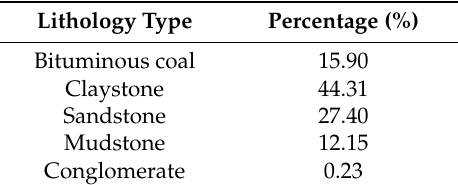
Table 1. The results of lithology modeling in the region of Pawłowice–Mizer ó w (USCB, Poland).